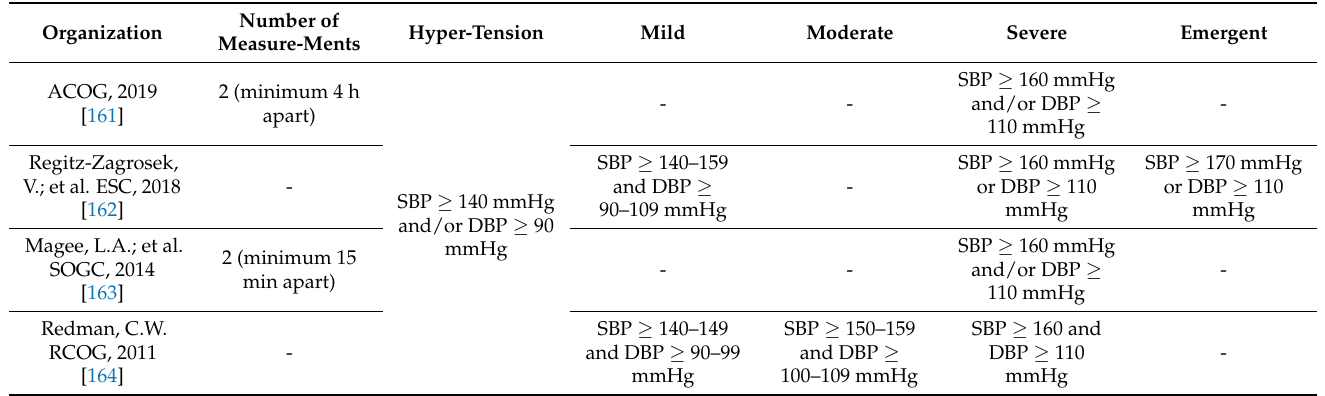
Table 5. Diagnostic criteria for